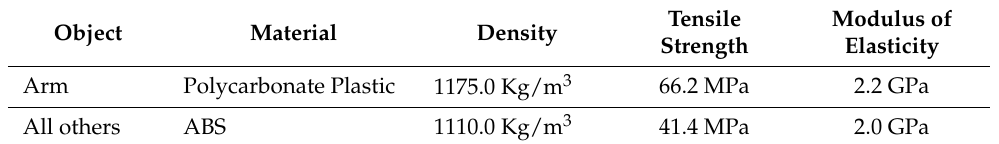
Table 2. Objects’ material type for the FEA